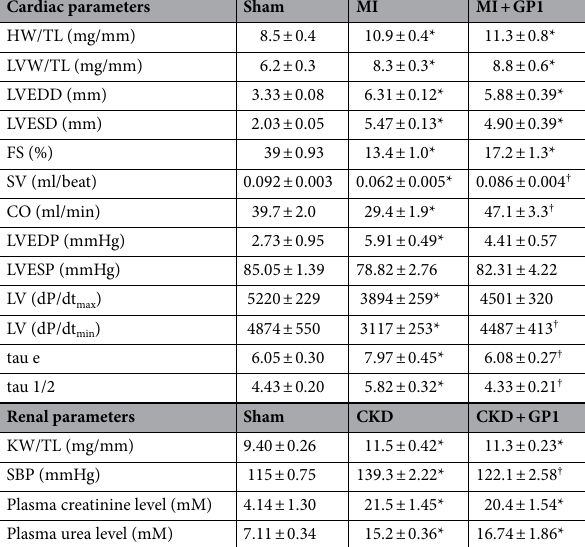
Table 1. Cardiac parameters in the myocardial infarction animal model and renal parameters in the chronic kidney disease animal model. HW/TL heart weight/tibia length; LVW/TL left ventricle weight/tibia length; LVEDD left ventricular end diastolic diameter; LVESD left ventricular end systolic diameter; FS Fractional shortening; SV stroke volume; CO cardiac output; LVEDP left ventricular end systolic pressure; LVESP Left ventricular end systolic pressure; LV dP/dT max and dP/dT min contractility and relaxation index, respectively; tau-e and tau ½ relaxation constants; KW/TL kidney weight/tibia length; SBP systolic blood pressure. *p < 0.05 vs . Sham. † p < 0.05 vs. MI or CKD